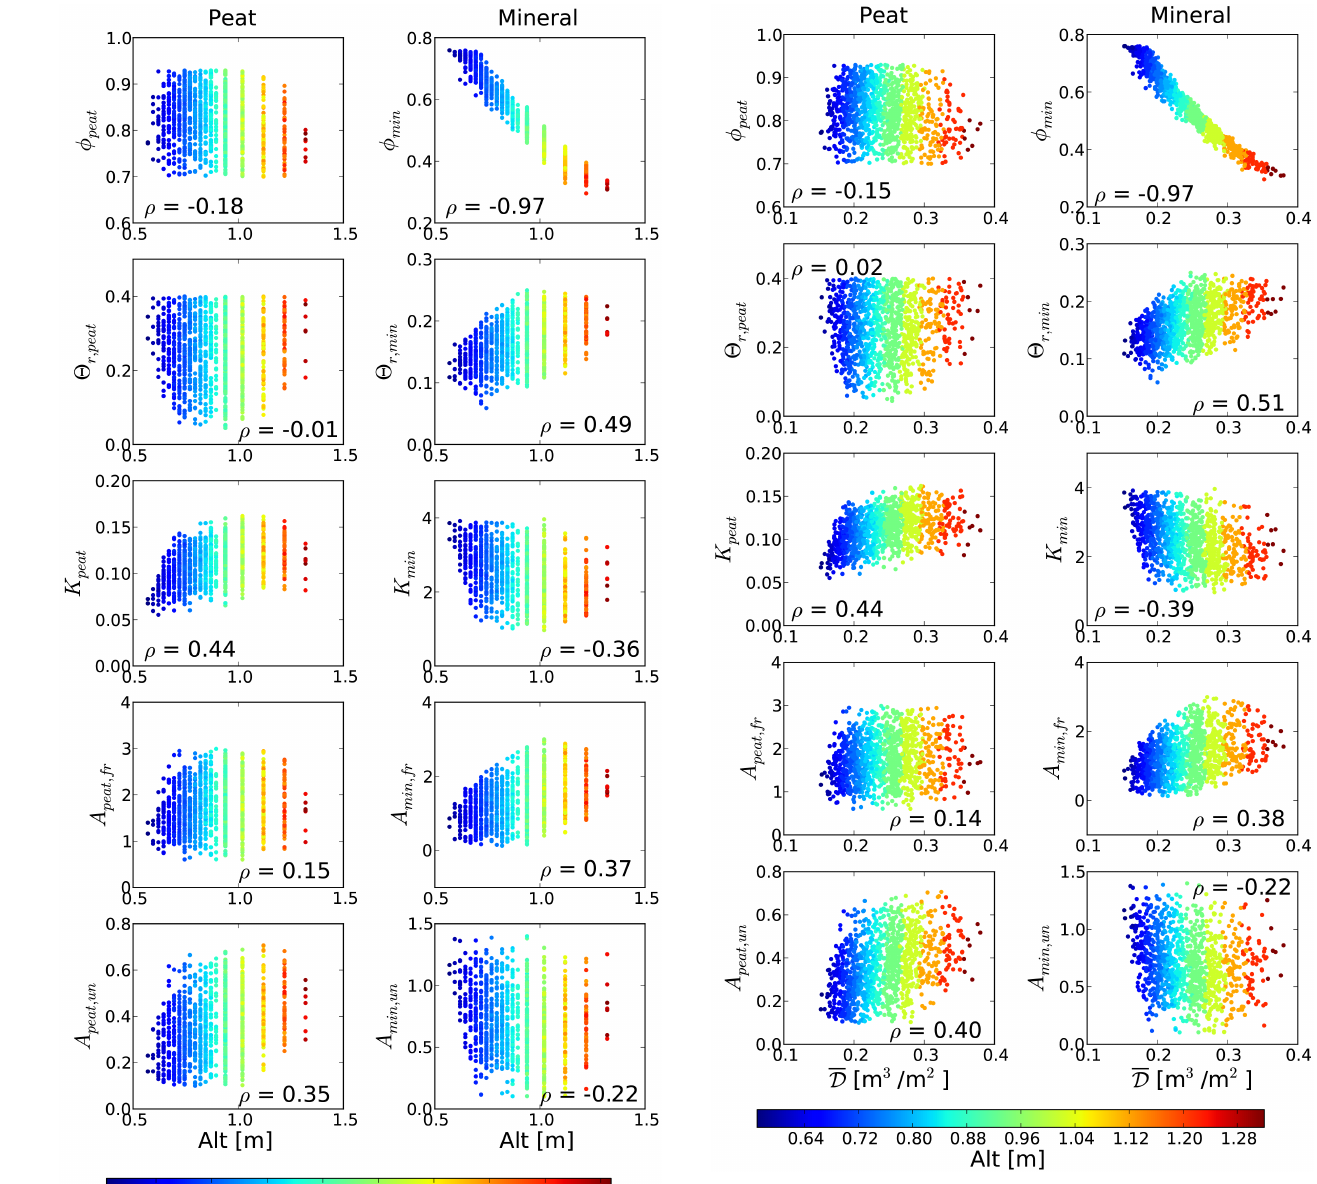
Figure 10. Scatterplots between calibration-constrained parameters and projected annual thaw depth-duration. Soil parameters associ- ated with peat are on the left and with mineral soil on the right (refer to column headings). Colors represent ALT. The associated Pearson correlation coefficient ρ is indicated in each